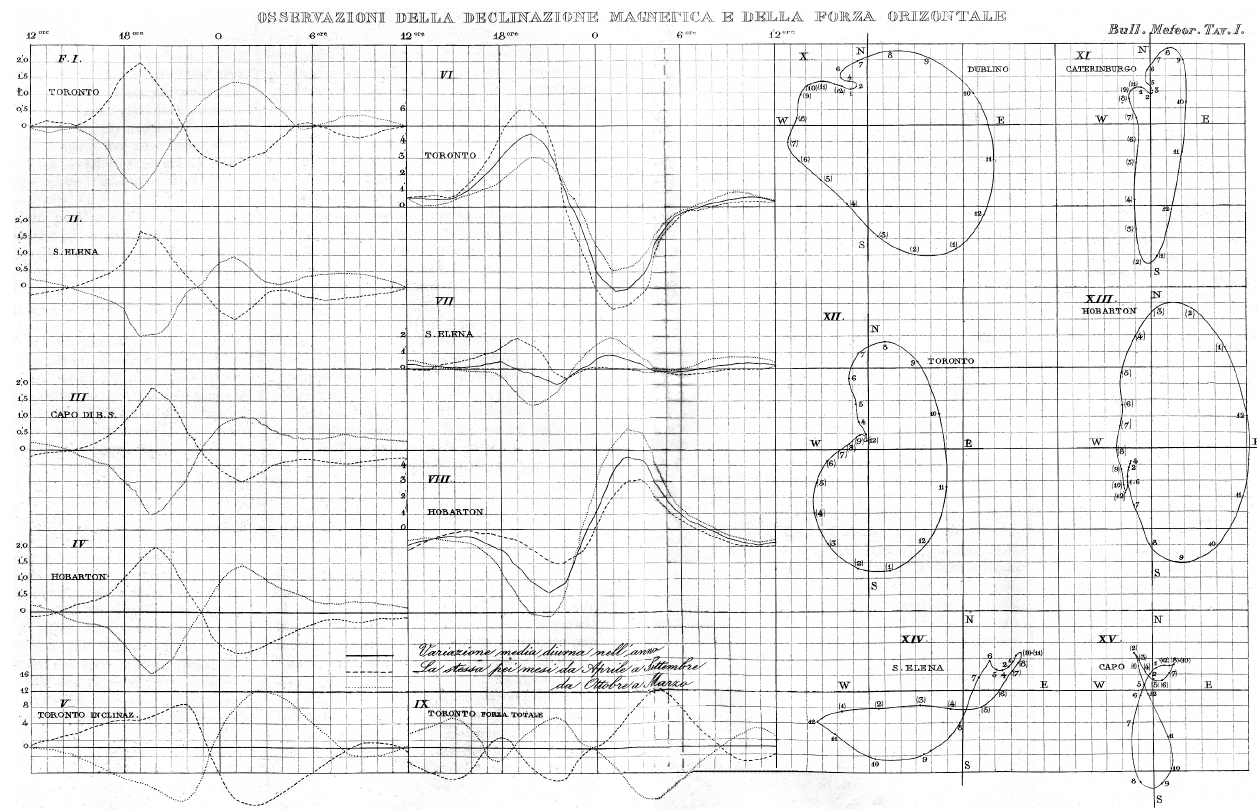
Figure 1. Diurnal variations of magnetic field registered by Humphrey Lloyd in di ff erent observatories, as reported by Secchi